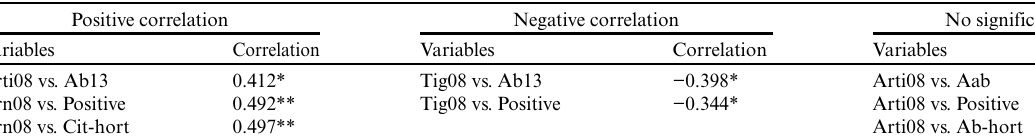
Table 3. Pearson correlations between factors that are assumed to promote resilience and the two dimensions of resilience (persistence and adaptability) with respect to municipalities. Abbreviations: Aab = speed of abandonment, Ab13 = rate of abandonment in 2013, Ab-hort = proportion of reversion to arable land, Arti08 = proportion of artichoke in 2008, Cab08 = proportion of cabbage in 2008, Citr-hort = proportion of conversion to arable land, Let08 = proportion of lettuce in 2008, Oni08 = proportion of onion in 2008, Orn08 = proportion of ornamental plant in 2008, Positive = incidence of positive changes, Pot08 = proportion of early potato in 2008, Ric08 = proportion of rice in 2008, SH08 = Shannon diversity index in 2008, Tig08 = proportion of tiger nut in 2008, Wme08 = proportion of watermelon in